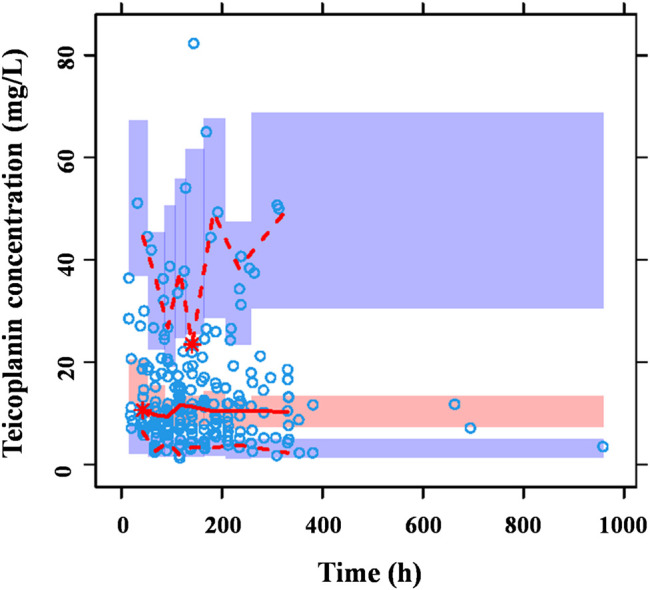
Prediction-corrected VPC generated from a Monte Carlo simulation (n = 1,000) for patients used in model development. The blue circles represent the prediction-corrected observed concentrations. The red solid line represents the median prediction-corrected observed concentrations and pink field represents simulation-based 95% confidence intervals for the median. The observed 5% and 95% percentiles are presented with red dashed lines and the 95% intervals for the model-predicted percentiles are shown as corresponding purple fields. VPC demonstrated that 90.7% observations fell within the 90% prediction interval of simulated concentrations out of 1,000 simulated data sets, indicating that the model-based simulated quantities were in good agreement with teicoplanin measured concentration.